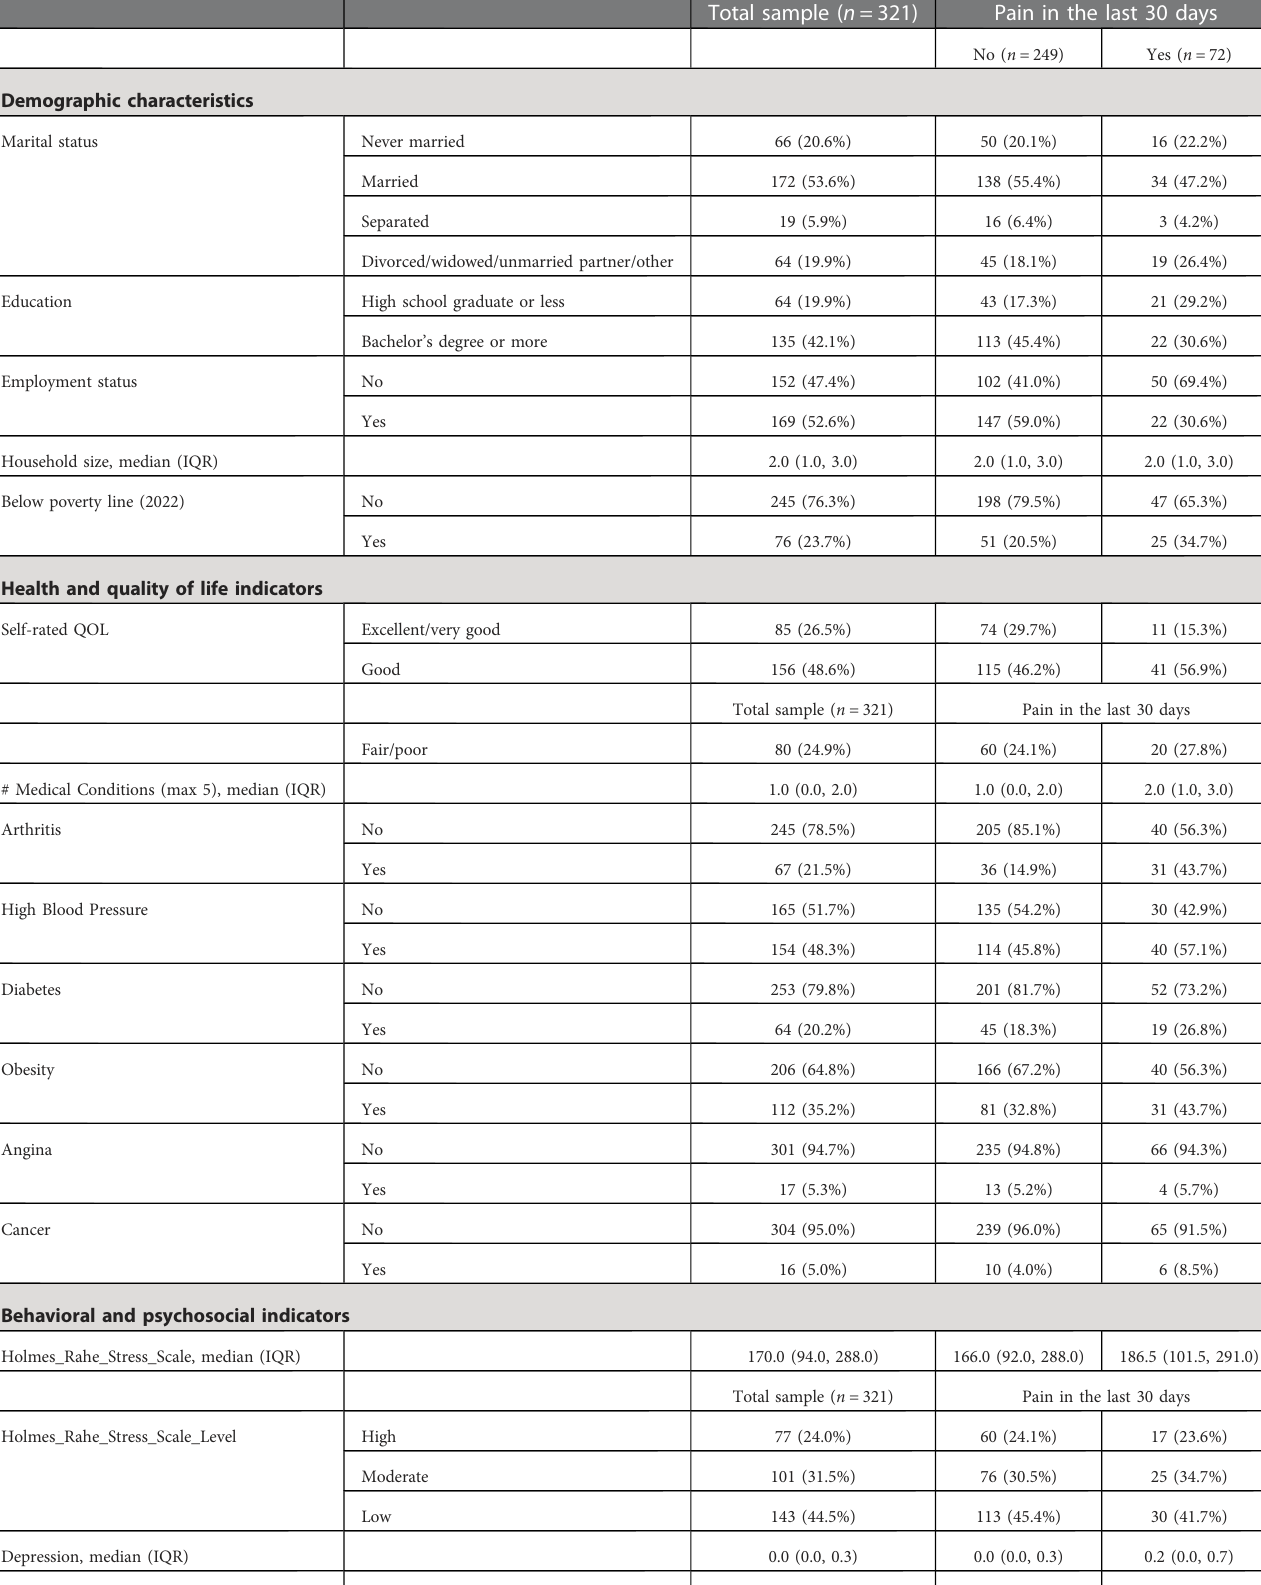
TABLE 1 Sociodemographic and health characteristics ( n